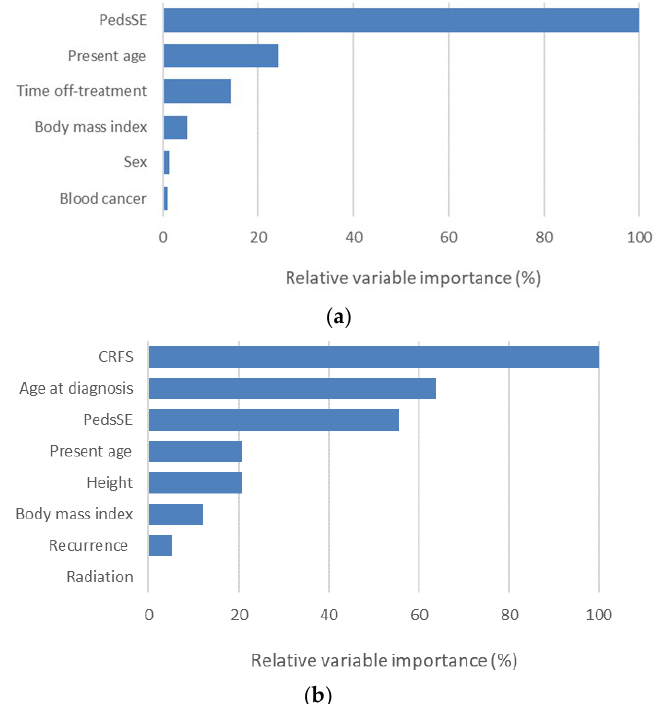
Figure 2. Ranking of important variables identified by random forest algorithm of regression ( a ) for prediction of cancer-related fatigue (CRHS) or binomial classification and ( b ) for distinction of low- PedsQL survivors in childhood cancer survivors ( n =